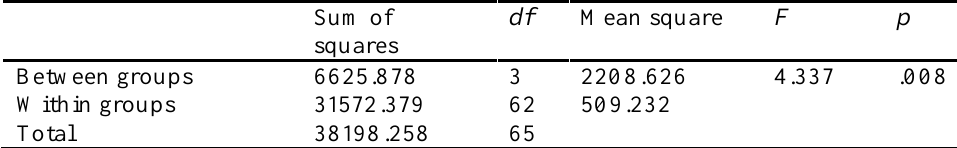
ANOVA Results between Average Scores of the Four Learning Style Groups Sum of